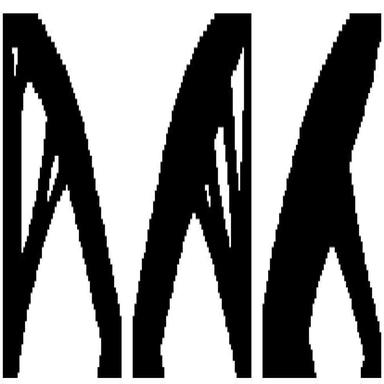
Three typical designs from topology optimization.